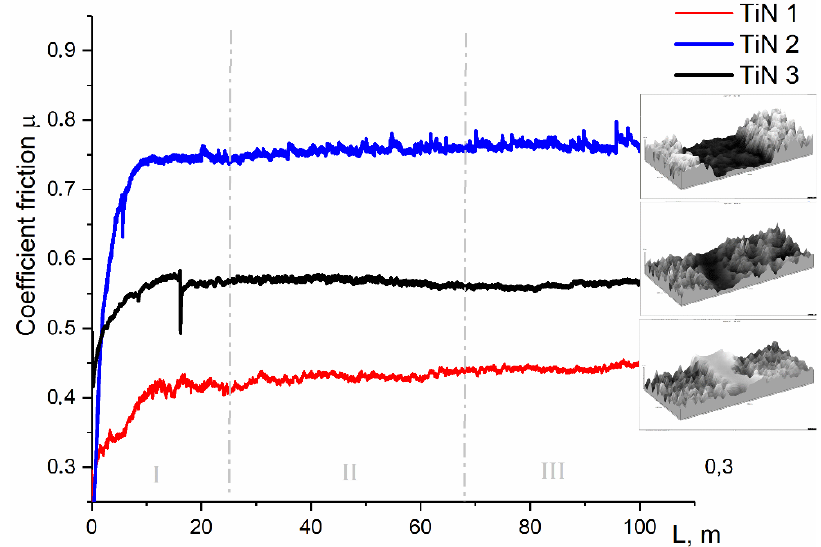
Figure 11. Dependence of friction coefficient of coatings on the friction path length.